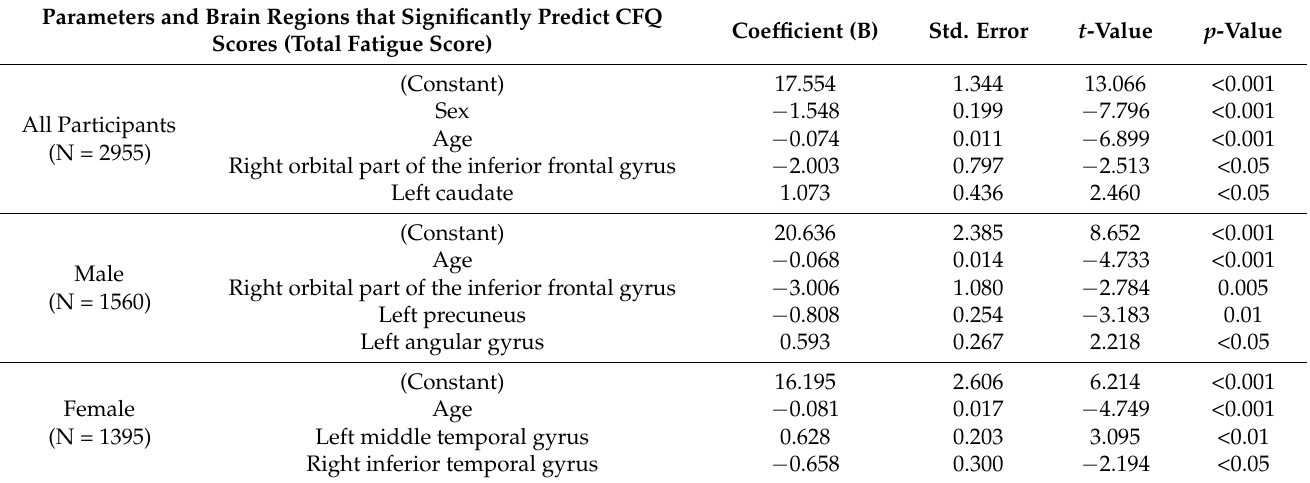
Table 2. Linear regression (stepwise-forward) analysis results with CFQ scores as the target variable and age and volume of the brain regions as the independent